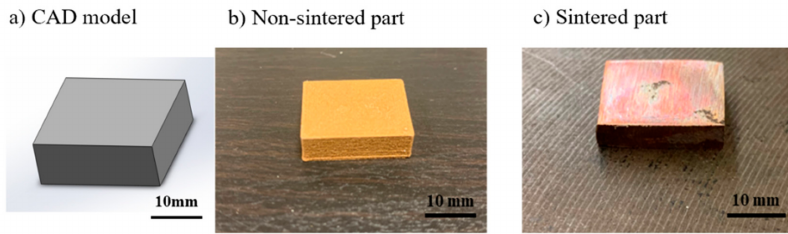
Figure 2. Samples in different status ( a ) CAD model ( b ) Bronze-PLA sample ( c ) sample after sintering and polishing.